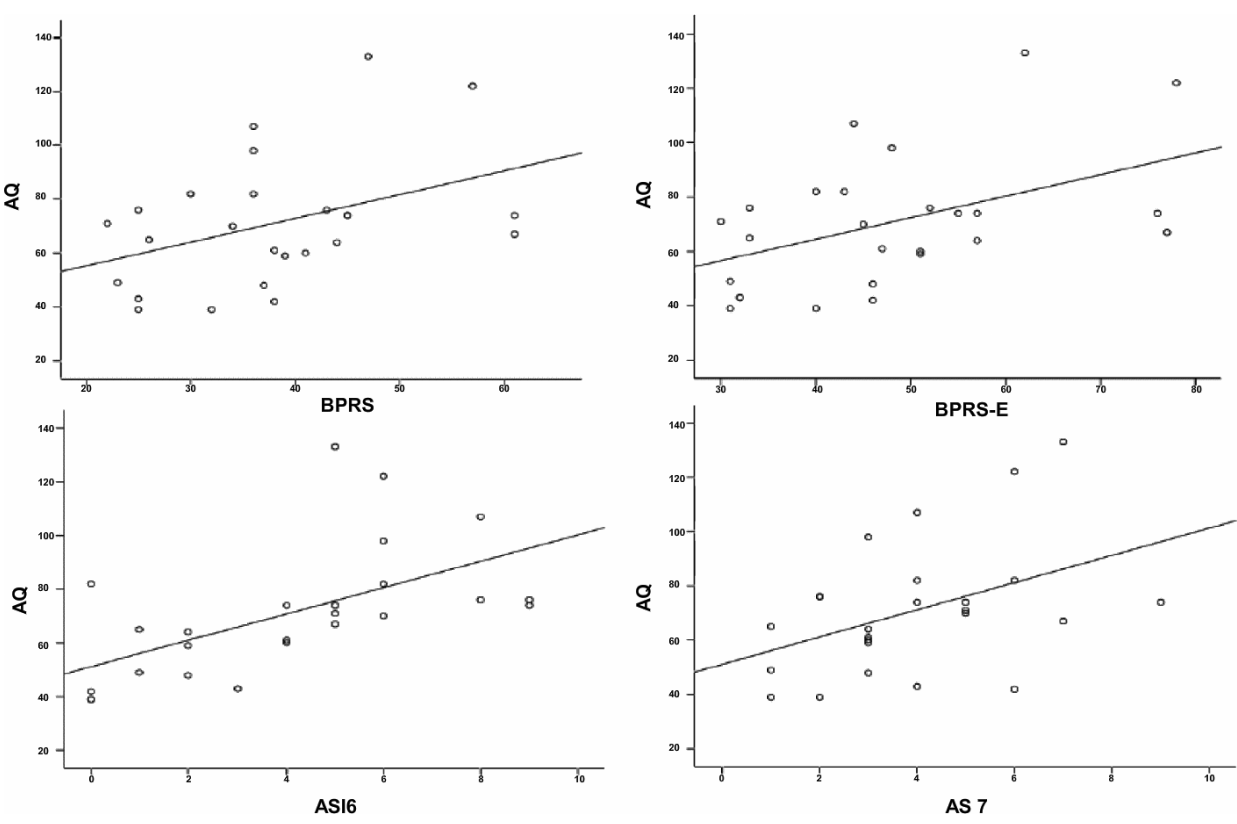
positive correlations were found between AQ and both BPRS ( r = 0.46, p = 0.02; top panel) and BPRS-E ( r = 0.40, p = 0.045; top panel); AQ and both ASI 6 ( r = 0.58, p = 0.002; bottom panel) and ASI 7 ( r = 0.43, p = 0.031; bottom